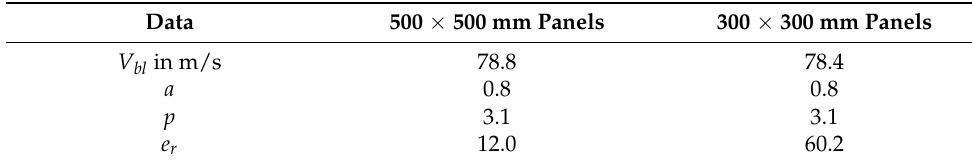
Table 4. R&I characteristic parameters and sum of squared residual error ( e r ) for 500 × 500 mm panels and 300 × 300 mm